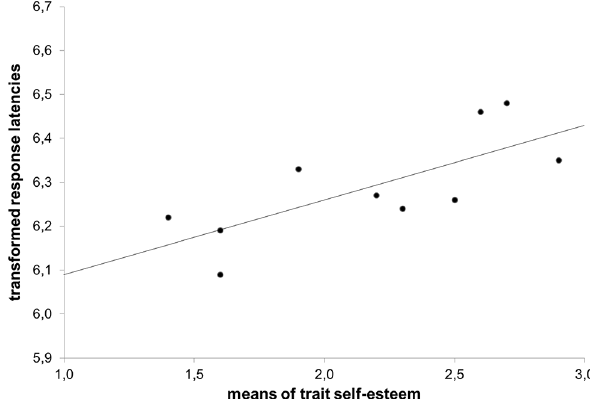
Fig 3. Scatter plot of the significant correlation between the log-transformed reaction times of the negative self-related traits and trait self-esteem under self-threat.